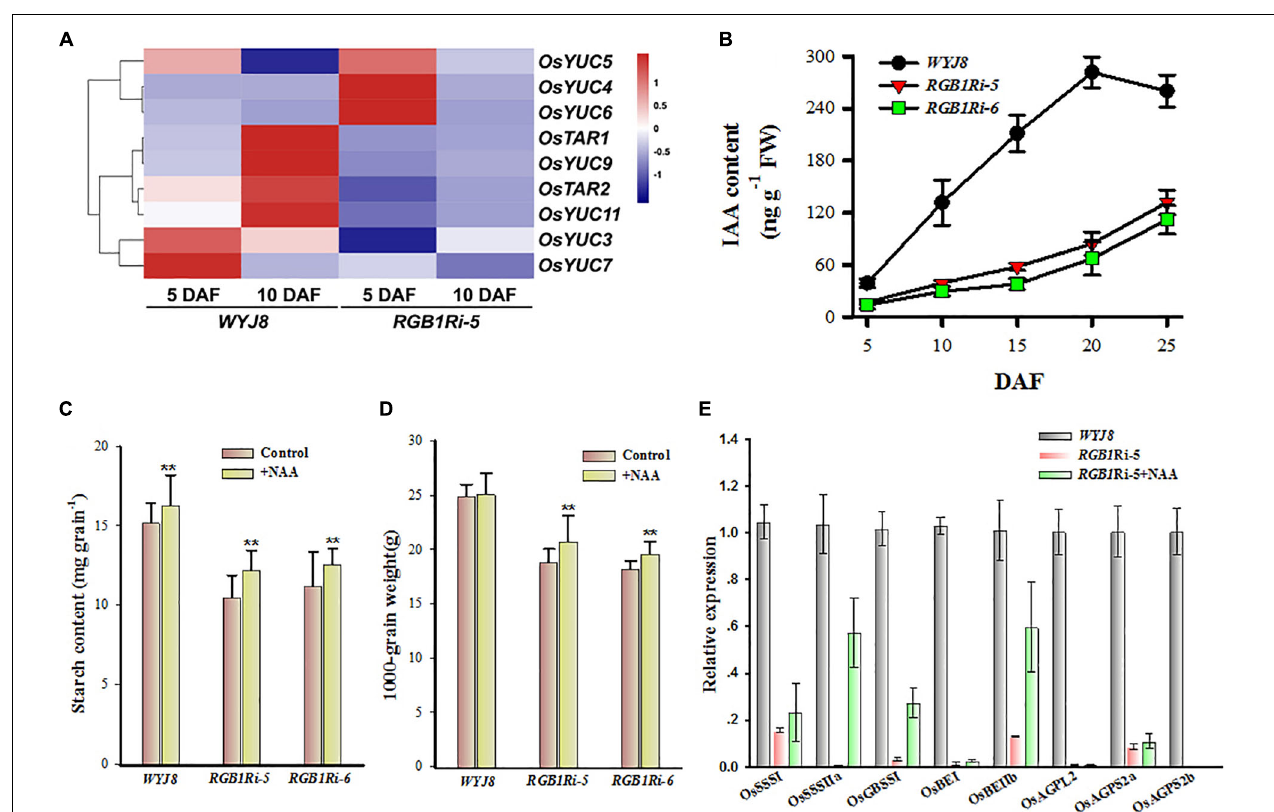
FIGURE 3 | Expressional profiles of auxin biosynthesis-related genes and changes in IAA in grains of WYJ8 plant and RGB1Ri line and effects of application of NAA on starch biosynthesis. (A) Heat maps of differentially expressed genes (DEGs) involved in auxin biosynthesis. The maps were plotted using the value of RPKM for each gene in the different samples: blue indicates low values; red indicates high values. The indicated scale is the log2 value of the normalized level of gene expression. (B) Changes in IAA level in rice endosperm cells of different genotypes during grain filling stage. (C) Effects of exogenous auxin (NAA) application on starch accumulation of grains of different genotypes. (D) Effects of exogenous auxin (NAA) application on grain weight of different genotypes. (E) Effects of exogenous auxin (NAA) application on the expression of genes related to sucrose metabolism and starch biosynthesis at 10 DAF. Data are shown as means ± SD s ( n = 5). **Means significant differences when P <